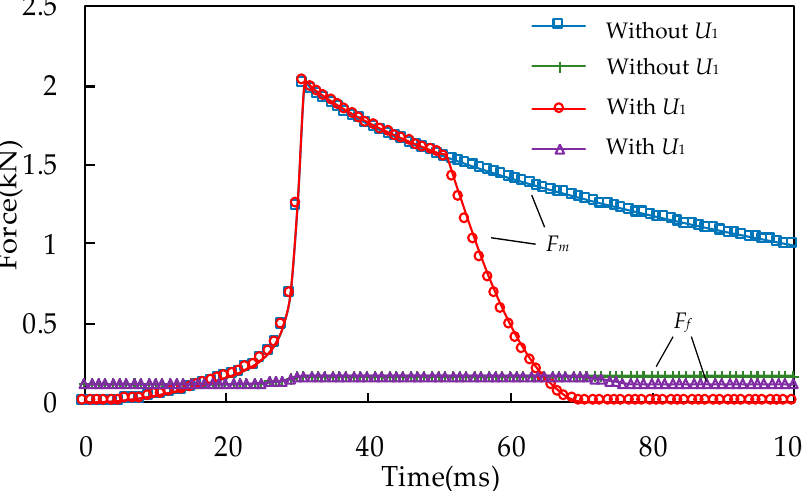
Figure 6. Simulation results of electromagnetic force and anti-force. The breaking command is applied at 50 ms.